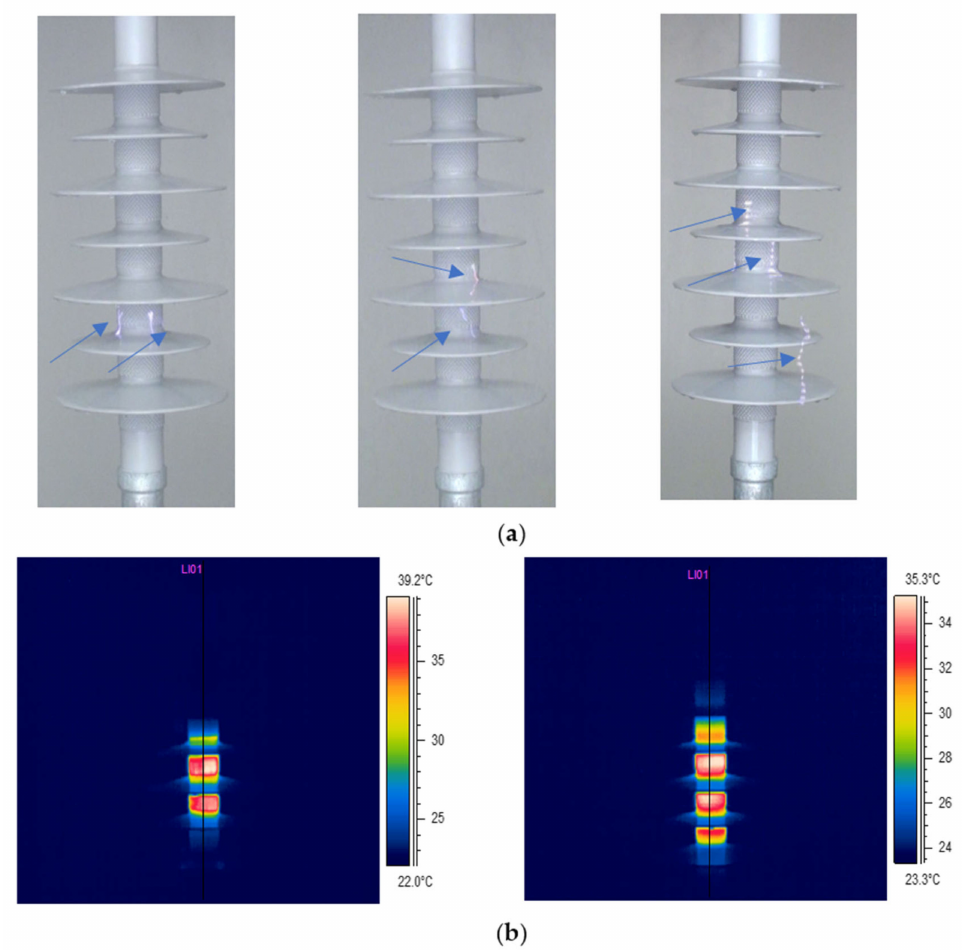
Figure 15. DBPA activity and IR images for heavy pollution over 40 kV rms ( a ) visual image of DBAs activity and ( b ) IR image of DB extension.